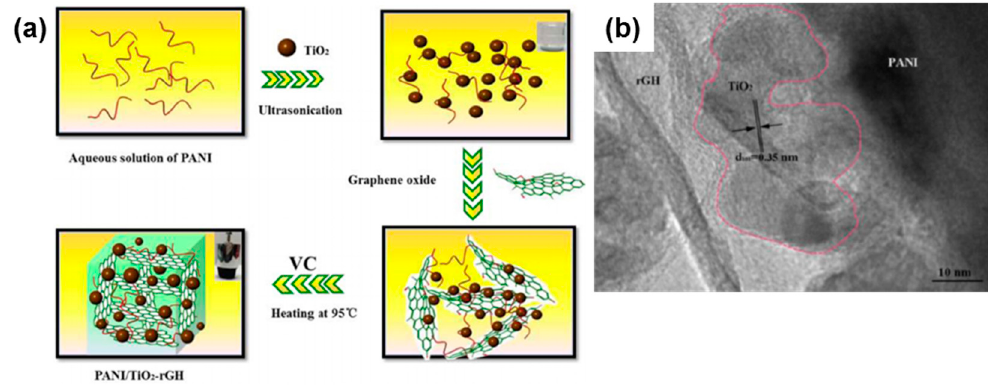
Figure 4. ( a ) Graphical illustration of fabrication of PANI/TiO 2 -rGH, ( b ) TEM of PANI/TiO 2 –rGH